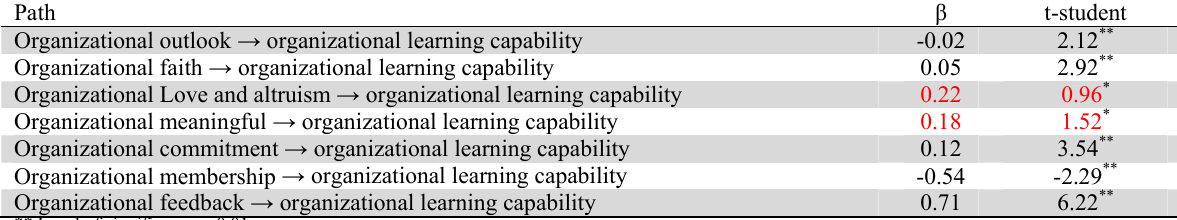
The results of testing seven hypotheses Path β Organizational outlook → organizational learning